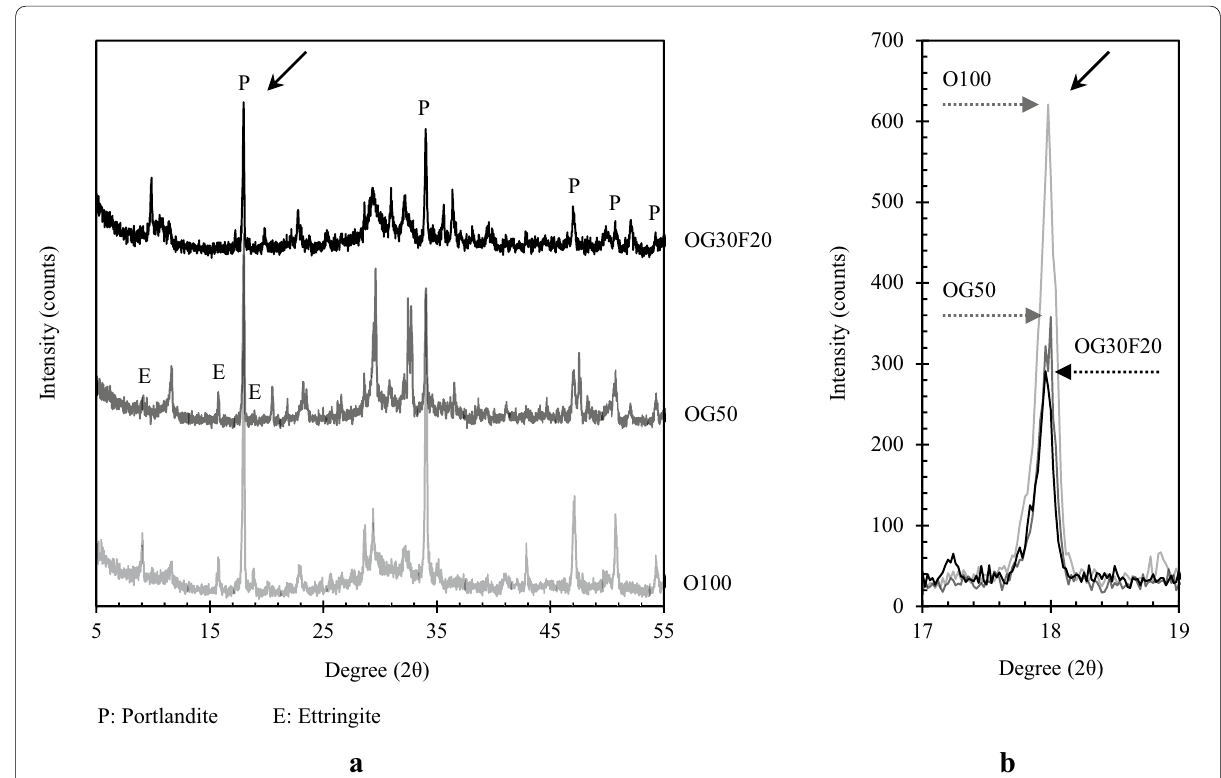
Fig. 2 XRD curves of cement pastes cured at 28 days with different mix proportions: a whole pattern; b main peak for